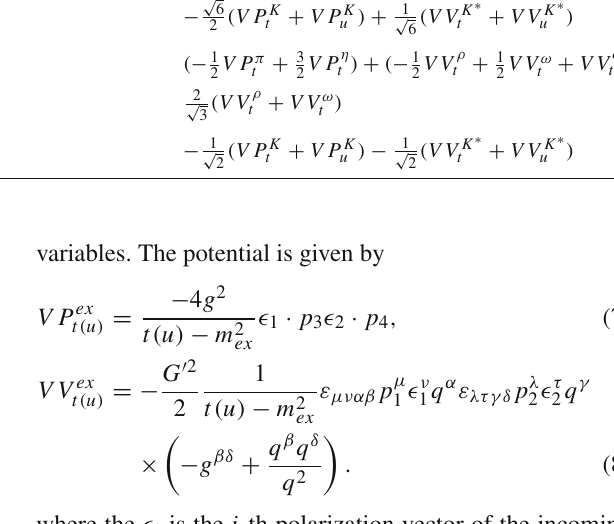
Table 1 The potential of each channel with